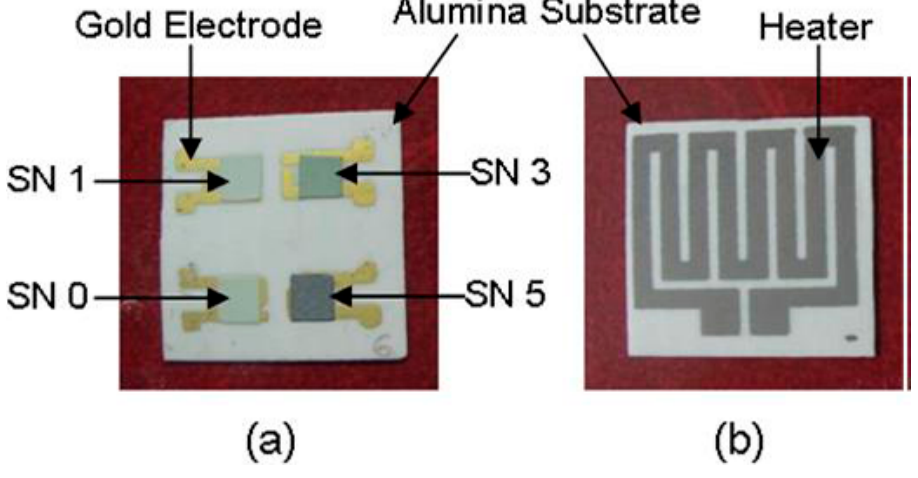
Figure 22. Sensor array, ( a ) front, ( b ) back [88].